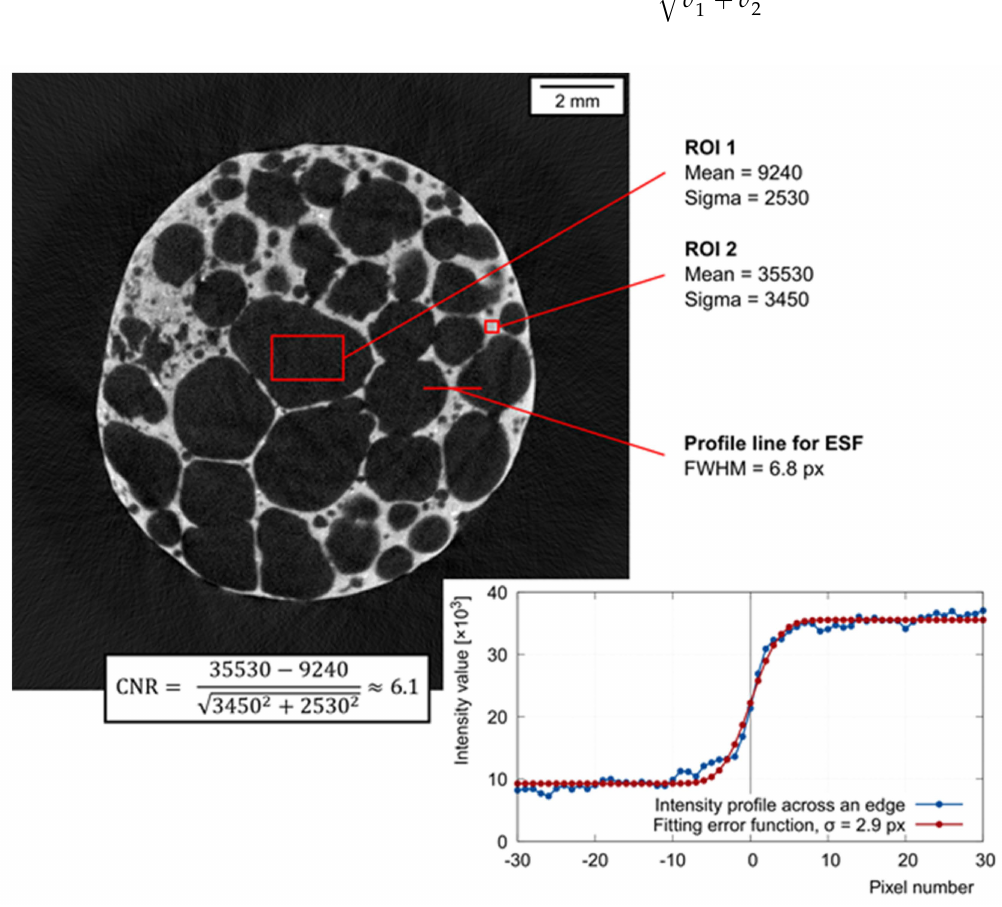
Figure 5. Transversal section of the tomographic model of the APM foam element. ROI1, ROI2—dark and bright area for the calculation of CNR; intensity profile across the edge is fitted with an error function and the FWHM is estimated. The intensity profile across a sharp edge in the image is called the edge spread function (ESF) and its derivative is the line spread function LSF, having a bell-shape. The width of LSF in 50% of its height is the FWHM value. The lower FWHM, the sharper the